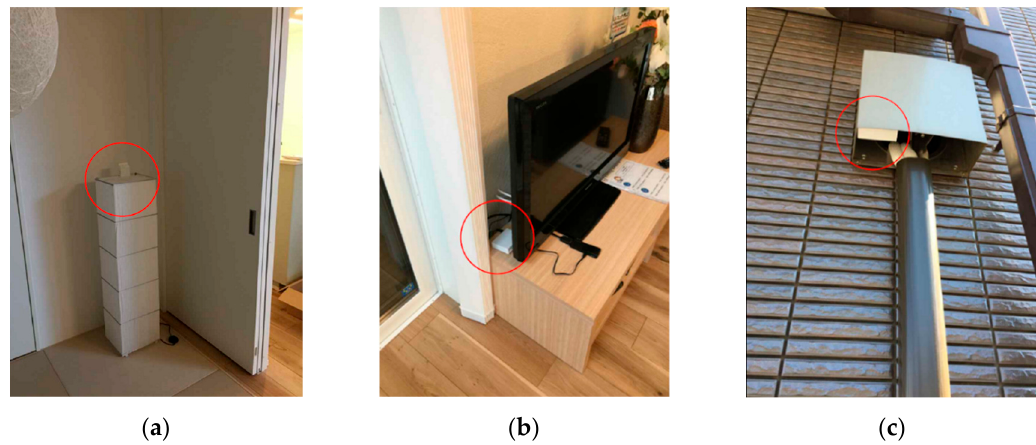
Figure 5. Installment of environmental sensors: ( a ) A thermometer in the room, ( b ) CO 2 sensor, ( c ) a thermometer on the outside north-facing wall. Sensors are circled in red.